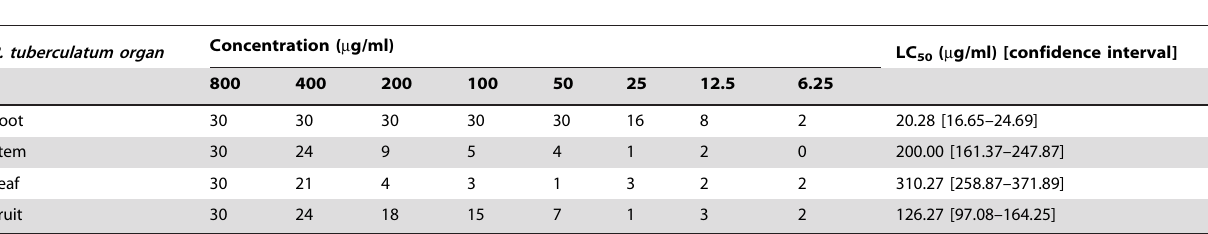
Table 1. Mortality of B. glabrata adults exposed to methanolic extracts of different organs of Piper tuberculatum .